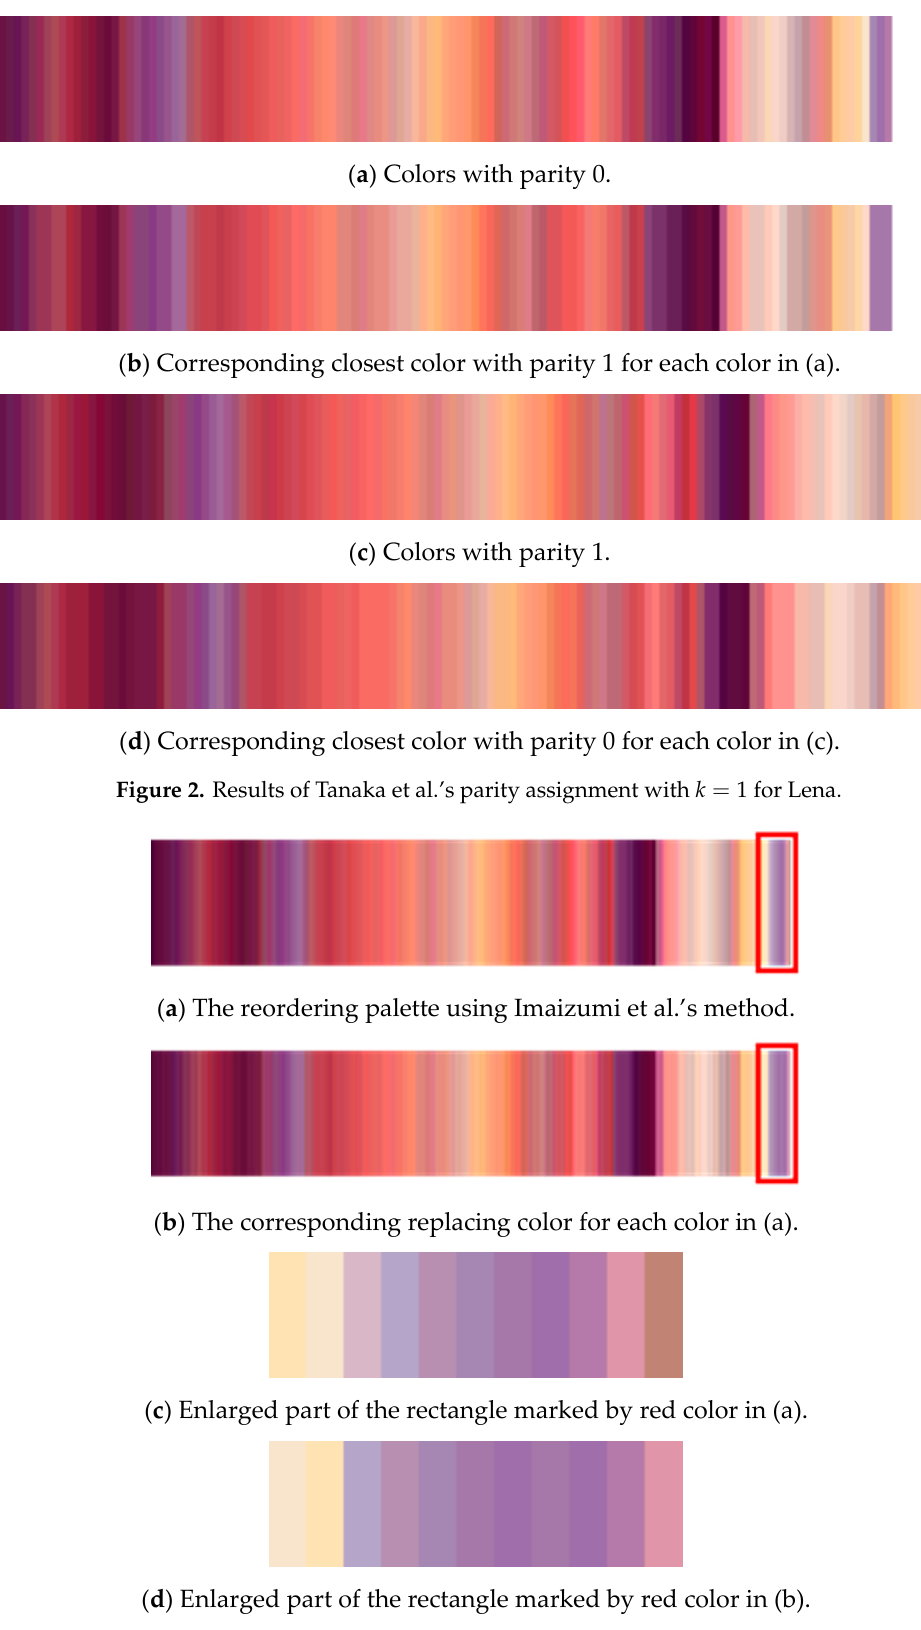
Figure 3. Results of Imaizumi et al.’s palette reordering for Lena.